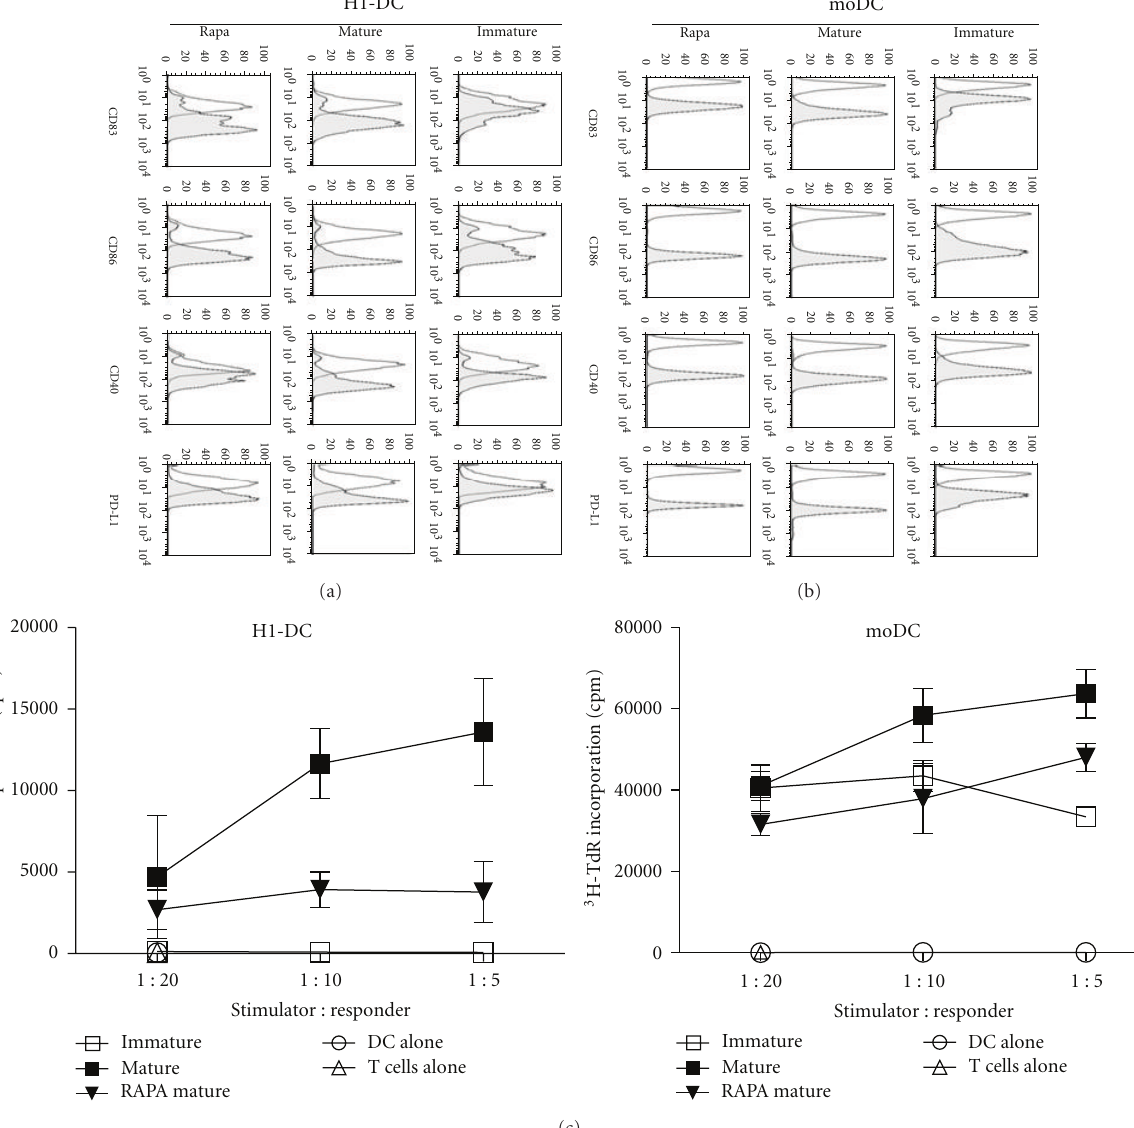
Figure 3: E ff ect of rapamycin (Rapa) on the phenotype and function of H1-DC. DCs were either untreated, matured in response to the maturation cocktail or treated with Rapa for 3 days prior to maturation. (a) H1-DC stained for the expression of the maturation marker CD83, the costimulatory molecules CD86 and CD40, as well as the inhibitory receptor PD-L1. Dead cells were excluded from analysis using 7-AAD. Open histograms represent the level of background staining using appropriate isotype-matched controls. Data from one of 3 independent experiments are shown. (b) Phenotypic analysis of control populations of moDC treated and stained in parallel with rapamycin. (c) E ff ect of rapamycin on the allostimulatory capacity of DC in the allogeneic MLR. DCs were mitotically-inactivated using mitomycin C and plated in triplicate at a top dose of 10 4 cells per well of a 96-well round-bottomed plate; na¨ıve CD4 + T cells were plated at 5 × 10 4 cells/well. Cells were incubated for 5 days before pulsing with 3 H-thymidine overnight. Graphs show the mean of triplicate cultures ± S.D. Data are shown from one experiment, representative of 3 independent